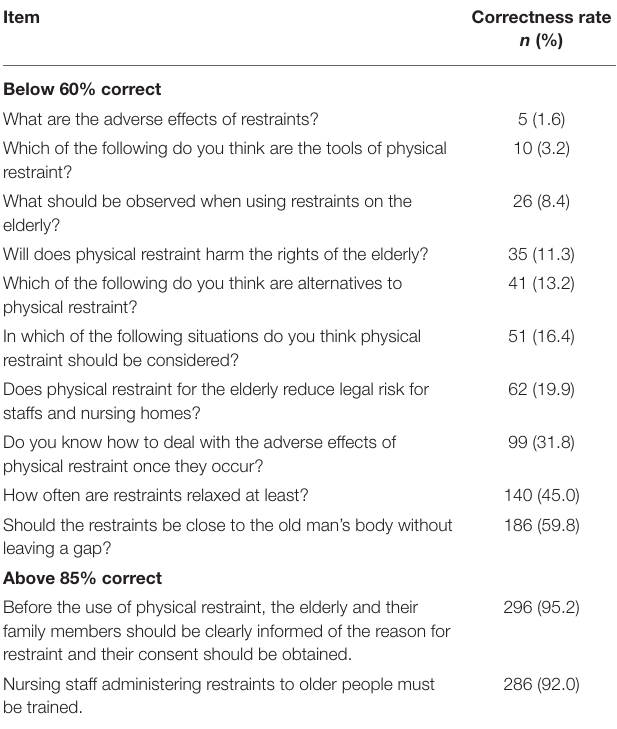
TABLE 1 | The scores of physical restraint knowledge ( N = 311).